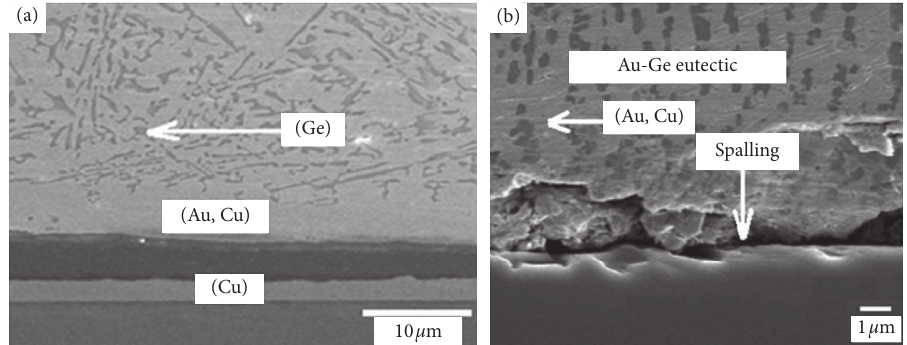
Figure 7: SEM-SEI micrographs of the cross section between Au-Ge eutectic solder and Cu/Au UBM: (a) without thermal aging and (b) after thermal aging for 500h at 300 ° C